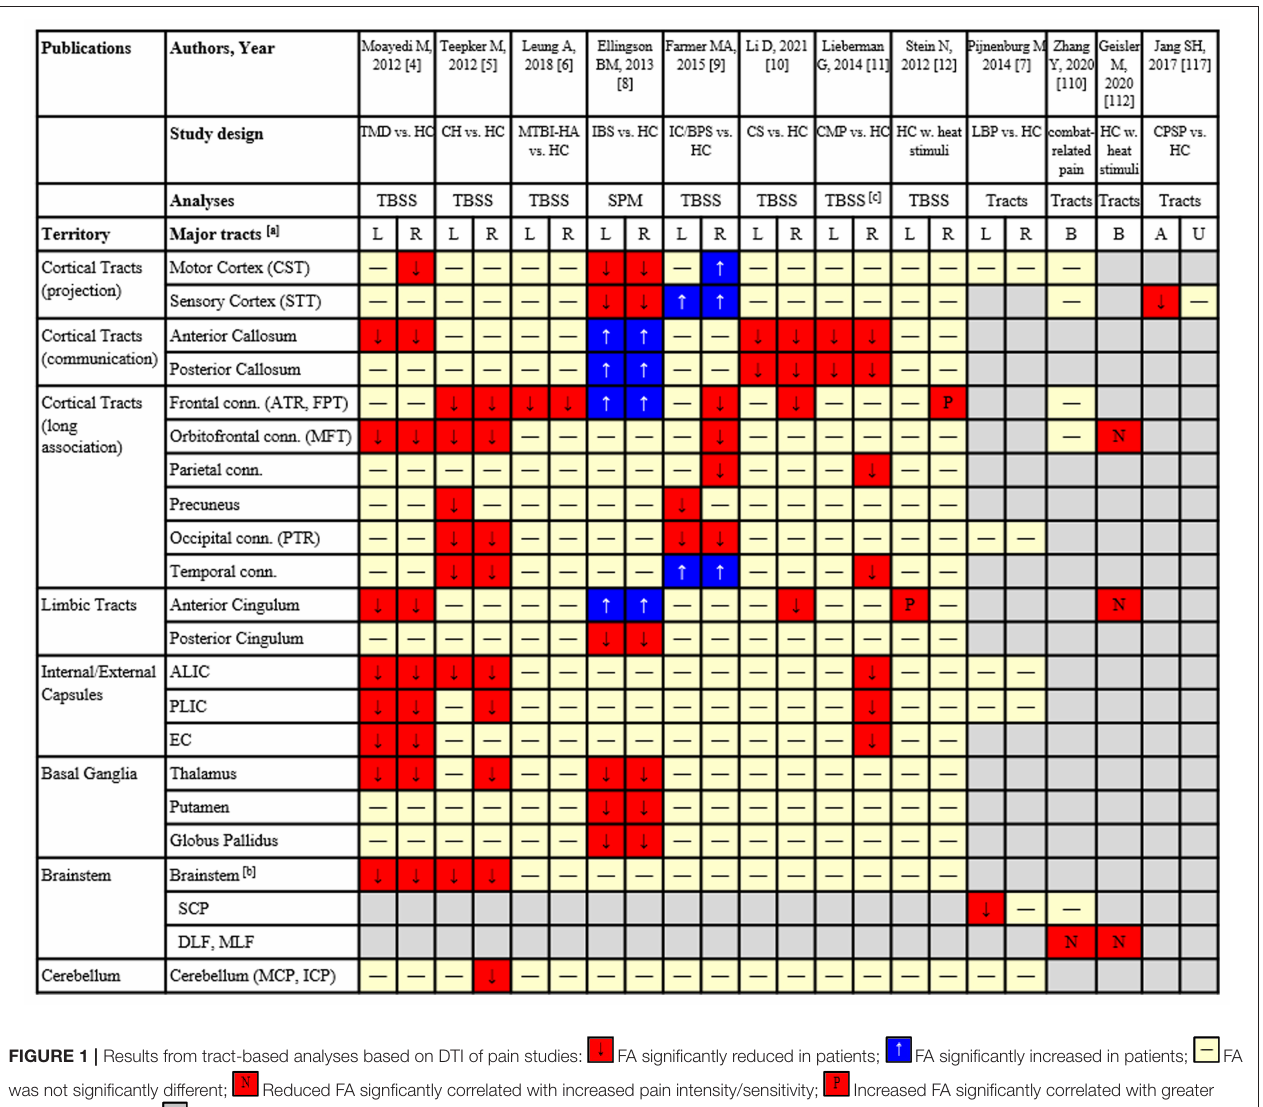
FIGURE 1 | Results from tract-based analyses based on DTI of pain studies: FA significantly reduced in patients; FA significantly increased in patients;